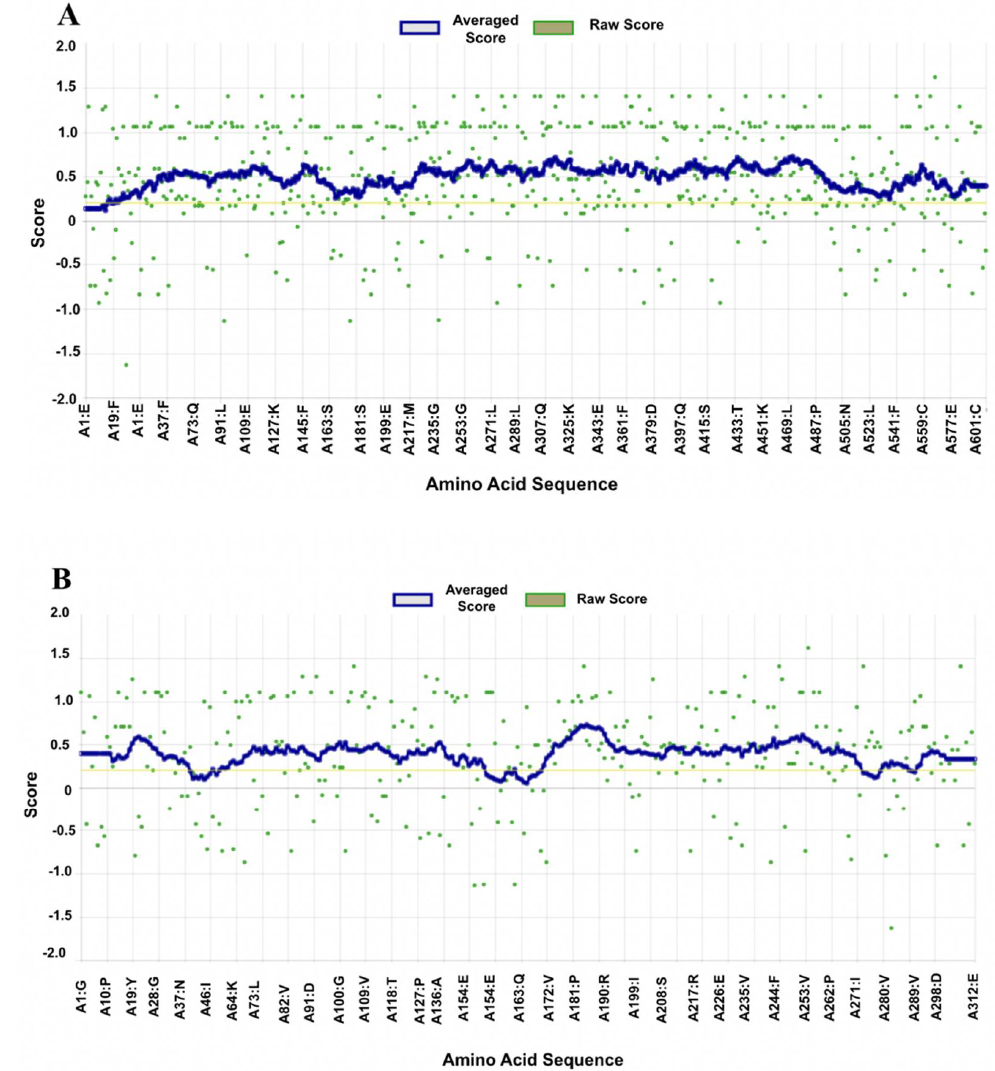
Figure 5. VERIFY3D plots showing at least 80% of the amino acids scored ≥ 0.2 in the 3D/1D profile: ( A ) TLR4 protein and ( B ) p50 ( A ) TLR4 protein and ( B ) p50 protein.